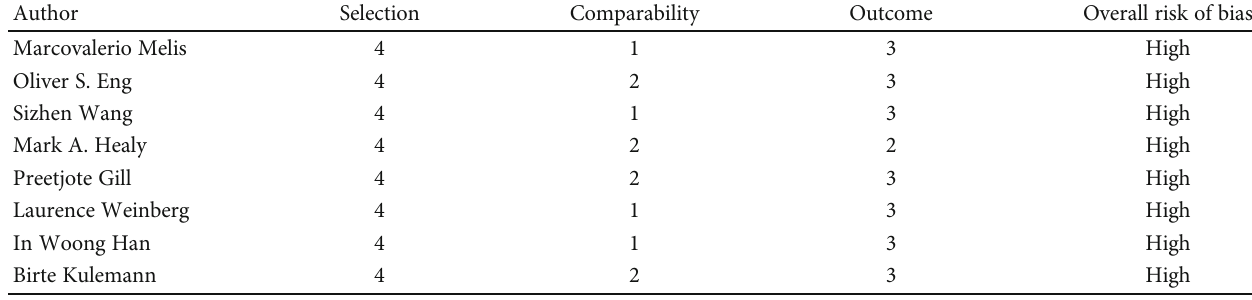
Table 3: Quality assessment of retrospective studies using the Newcastle-Ottawa Scale.